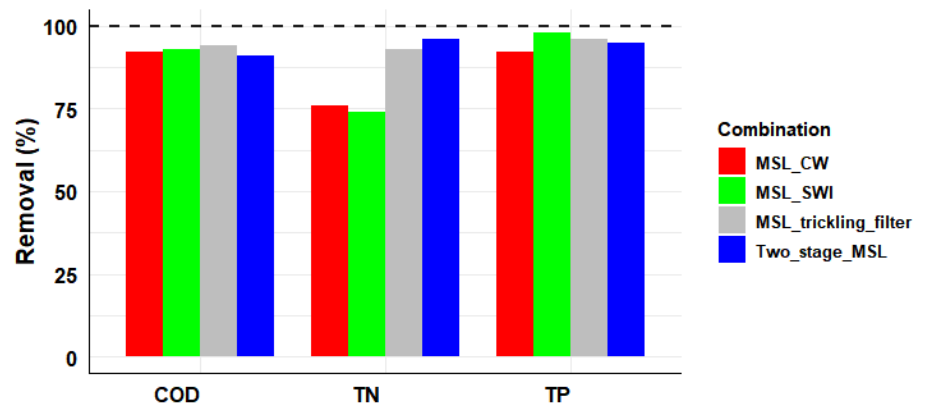
Figure 11. Pollutant removal efficiency by the reviewed combinations using bar charts.